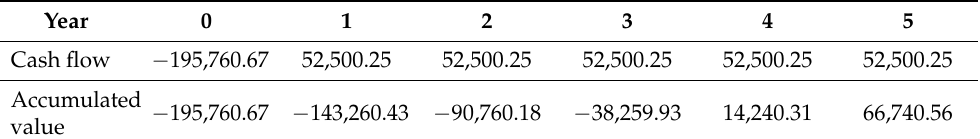
Table 8. Annual cash flow for the crude palm oil ( Elaeis guineensis , Jacq) and simple payback analysis.